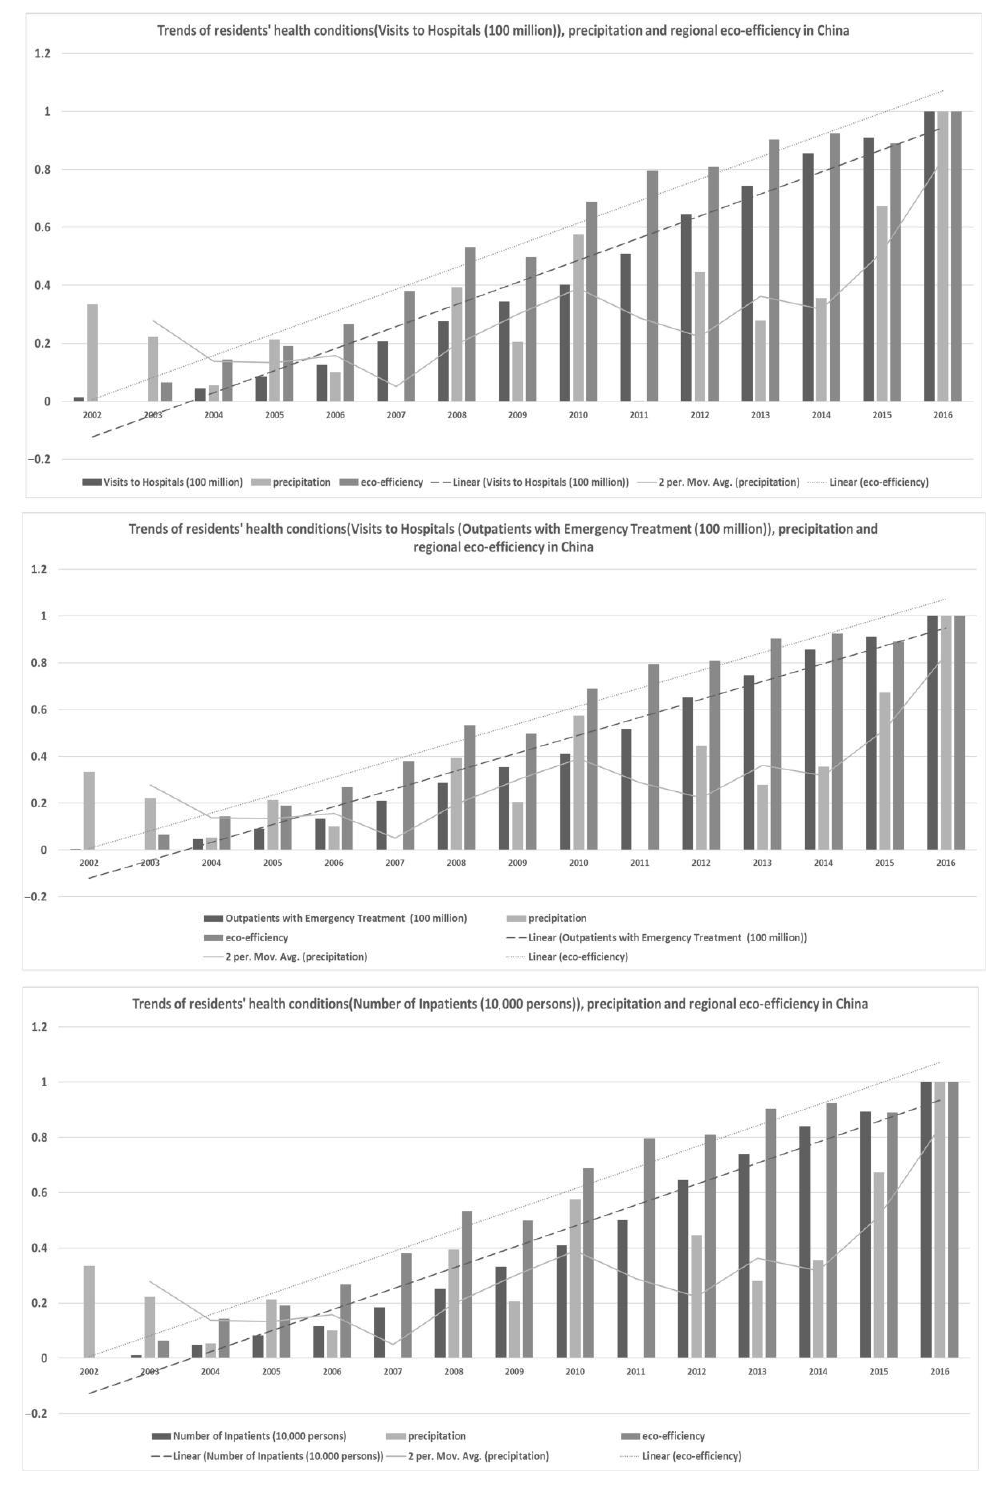
Figure 4. Trends of RHC , precipitation, and REE in China.